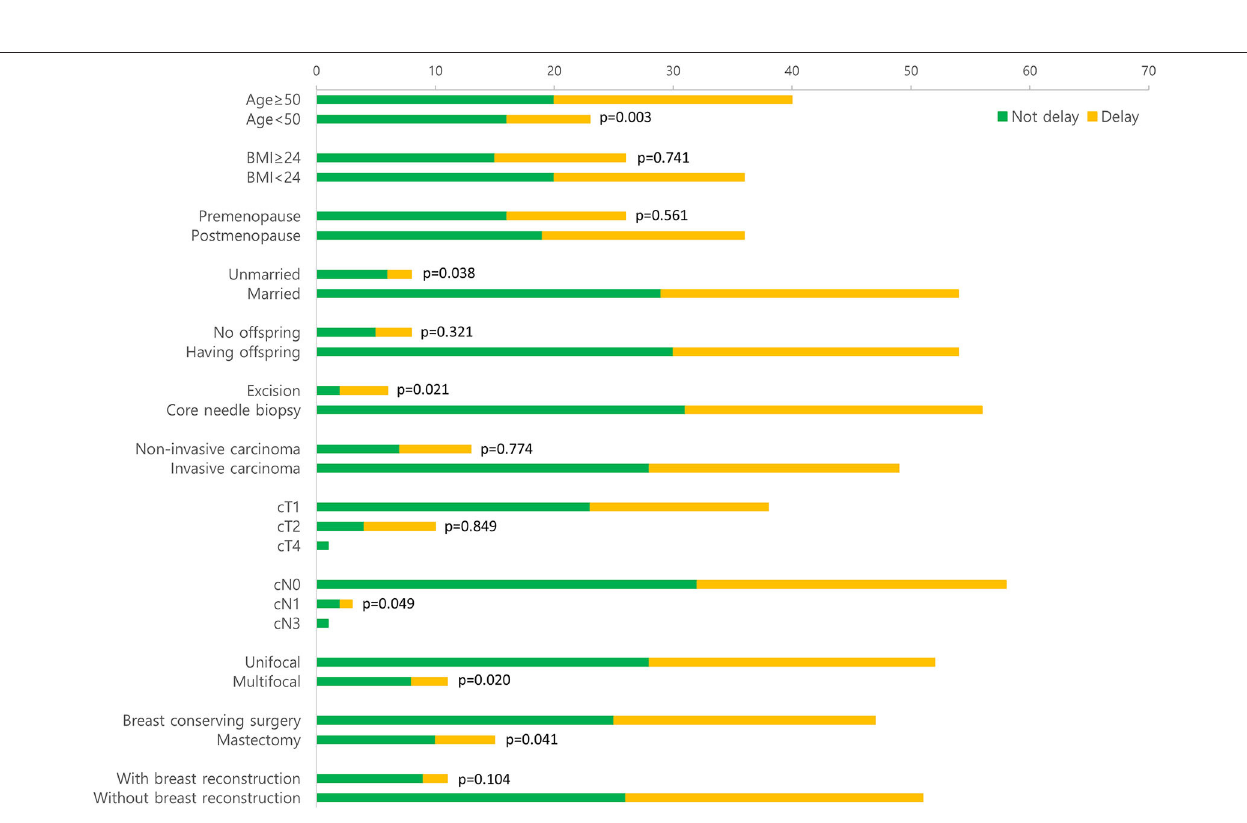
Frontiers in Surgery | www.frontiersin.org